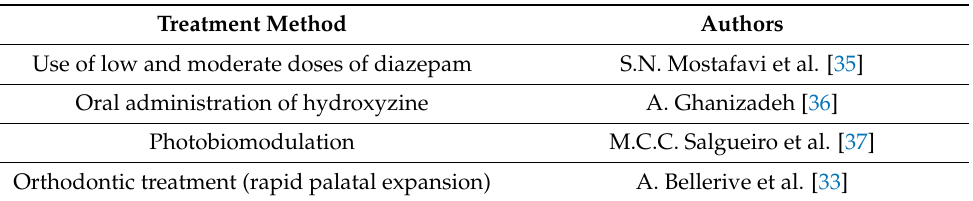
Table 2. Methods used for the treatment of SB in